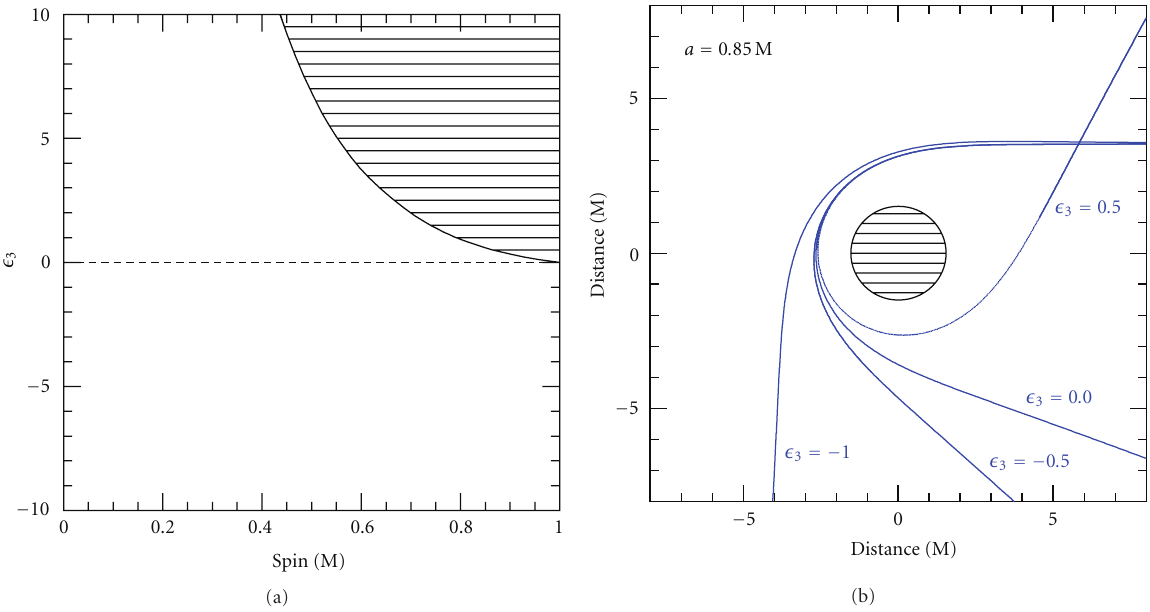
Figure 1: (a) Values of the parameter (cid:2) 3 versus the spin a , for which the central object is a black hole. The shaded region marks the excluded part of the parameter space where this object is a naked singularity. The dashed line corresponds to a Kerr black hole [34]. (b) Trajectories of photons lensed by a black hole with a (counterclockwise) spin a = 0 . 85M for several values of the parameter (cid:2) 3 . The shaded region corresponds to the event horizon of a Kerr black hole of equal